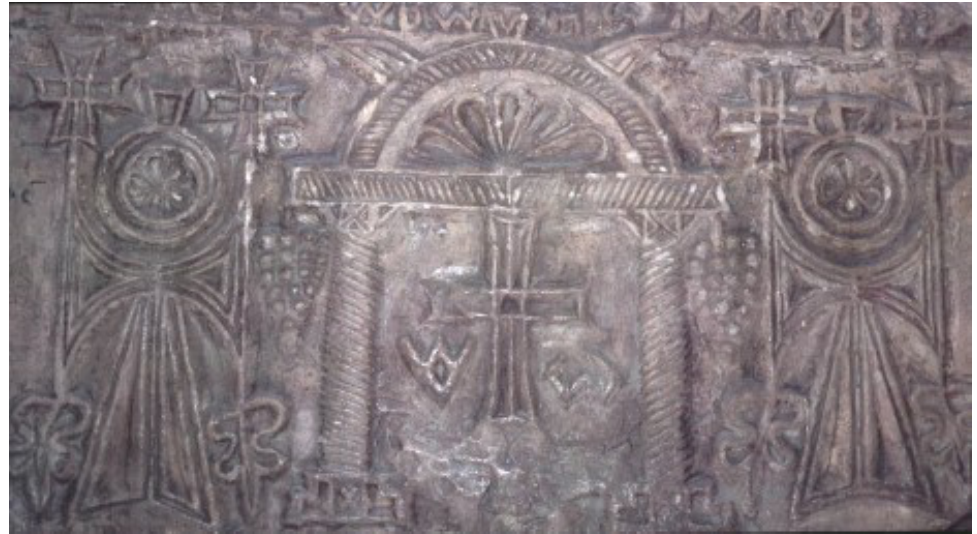
Figure 8. Lotus, ankh, and Coptic cross. Early Christian communities in Egypt symbolized the cross of Christ with their traditional ankh symbol. Note that the cross of Jesus—here identified with the Greek letters alpha and omega—supports a five-petaled palmette, radial views of which are observed within the “handle” (the Egyptian shen loop) of the crux ansata. The quasi-personified ankh signs, apparently emblematic of Christ himself, wear robes and uphold crosses and dangling grape leaves. Cairo, 3rd c. (Coptic Museum).